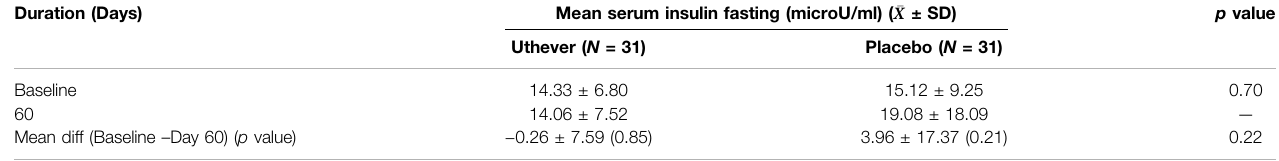
TABLE 8 | Comparison of changes in mean serum insulin (fasting) between